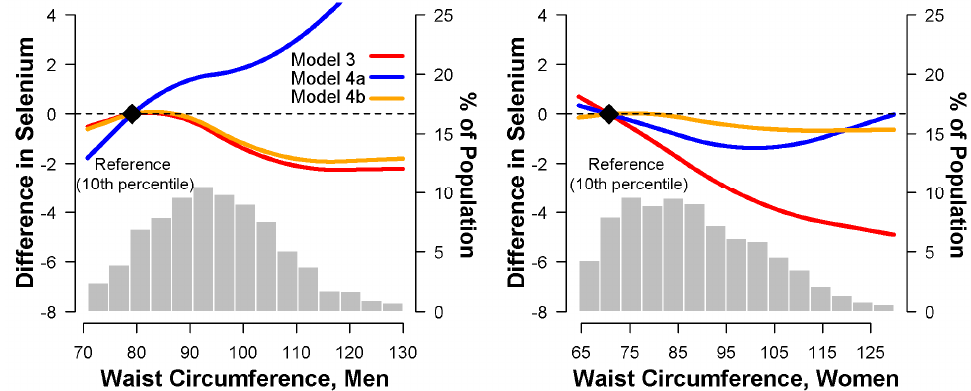
Figure 2. Multivariate ‐ adjusted difference in serum selenium (ng/mL) associated with waist circumference (cm), using restricted quadratic spline models. Model 3 (red line) was adjusted for age (continuous), race/ethnicity (non ‐ Hispanic white, non ‐ Hispanic black, Mexican American, other), education (<12 years, ≥ 12 years), postmenopausal status for women (yes, no), smoking (never, former, current), serum cotinine (continuous), sedentary lifestyle (yes, no), diabetes (yes, no), C ‐ reactive protein (<0.3, ≥ 0.3 to <1, ≥ 1 mg/dL), systolic blood pressure (continuous), antihypertensive medication (yes, no), total cholesterol (continuous), triglycerides (continuous), and high density lipoprotein cholesterol (continuous). Model 4a (blue line) was further adjusted for body mass index (continuous); and model 4b (orange line) was further adjusted for percent body fat (continuous) in addition to covariates in model 3. The reference values (diamond dots) were set at the 10th percentile of the sample distribution of waist circumference.